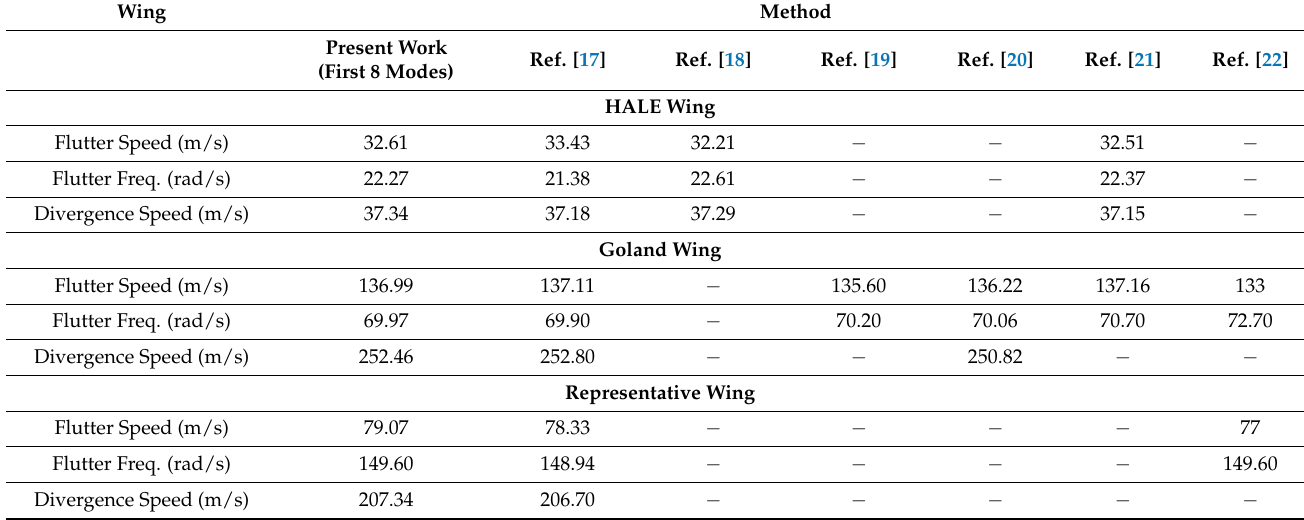
Table 3. The validation of the FE aeroelastic